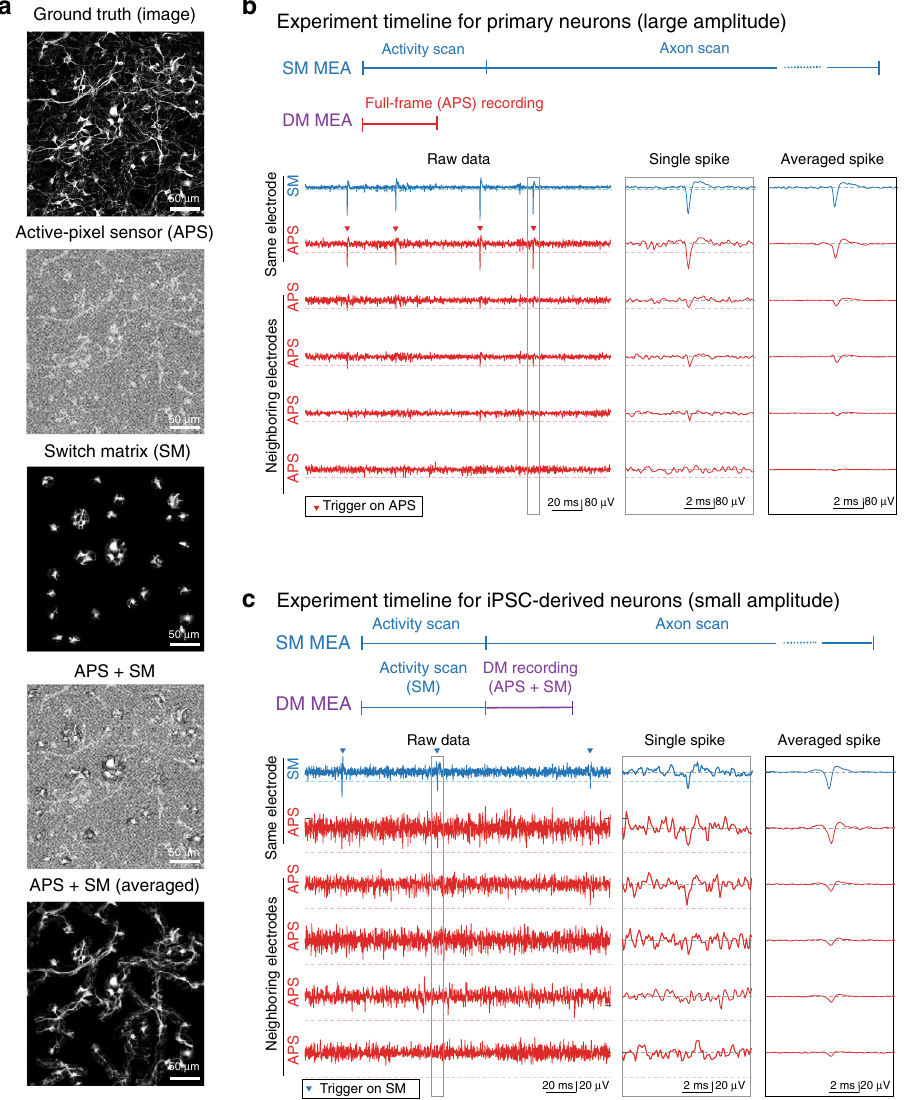
Fig. 2 Key concept of SM, APS, and combined readouts. a Illustration of the DM concept, using optical images of primary neurons instead of electrical recording to outline the concept. b Experimental work fl ow for primary neurons (including comparison to SM-only HD-MEAs), and simultaneous recording by using APS and SM modes. Primary neurons provide clearly visible spikes in the raw data acquired in both modes. The electrical footprints can be extracted by spike-triggered averaging using either of the modes. The topmost two signal traces in SM and APS mode have been recorded from the same electrode featuring the largest signal amplitude. Both modes provide large enough signals and clear trigger points ( fi lled triangles). c Experimental work fl ow for iPSC-derived neurons (including comparison to SM-only HD-MEAs), and simultaneous recording by using APS and SM modes. IPSC-derived neurons typically yield rather small-amplitude spikes, which can be detected in the SM data but not in the APS data. The electrical footprints can then be extracted by spike-triggered averaging of APS data using the SM mode and the spikes extracted from the SM mode as trigger signals. Again, the topmost two signal traces in SM and APS mode have been recorded from the same electrode featuring the largest signal amplitude. Only the SM mode provides a large enough signal-to-noise ratio and clear trigger points ( fi lled